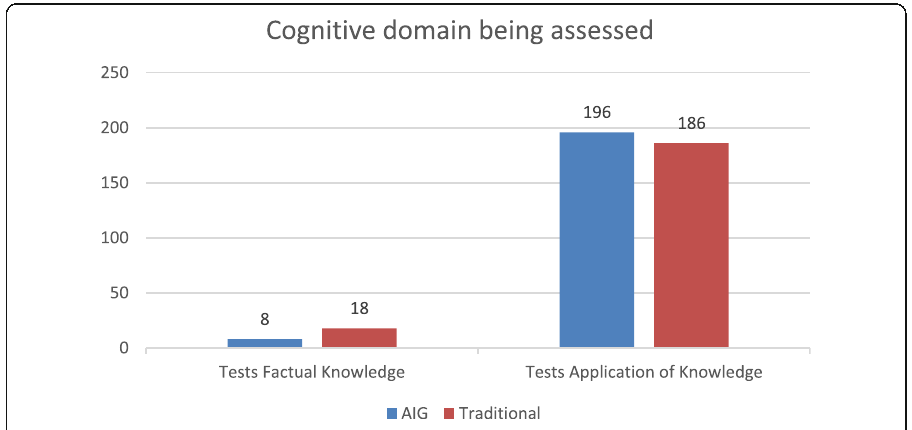
Fig. 3 Frequency distributions for cognitive domain judgment by item